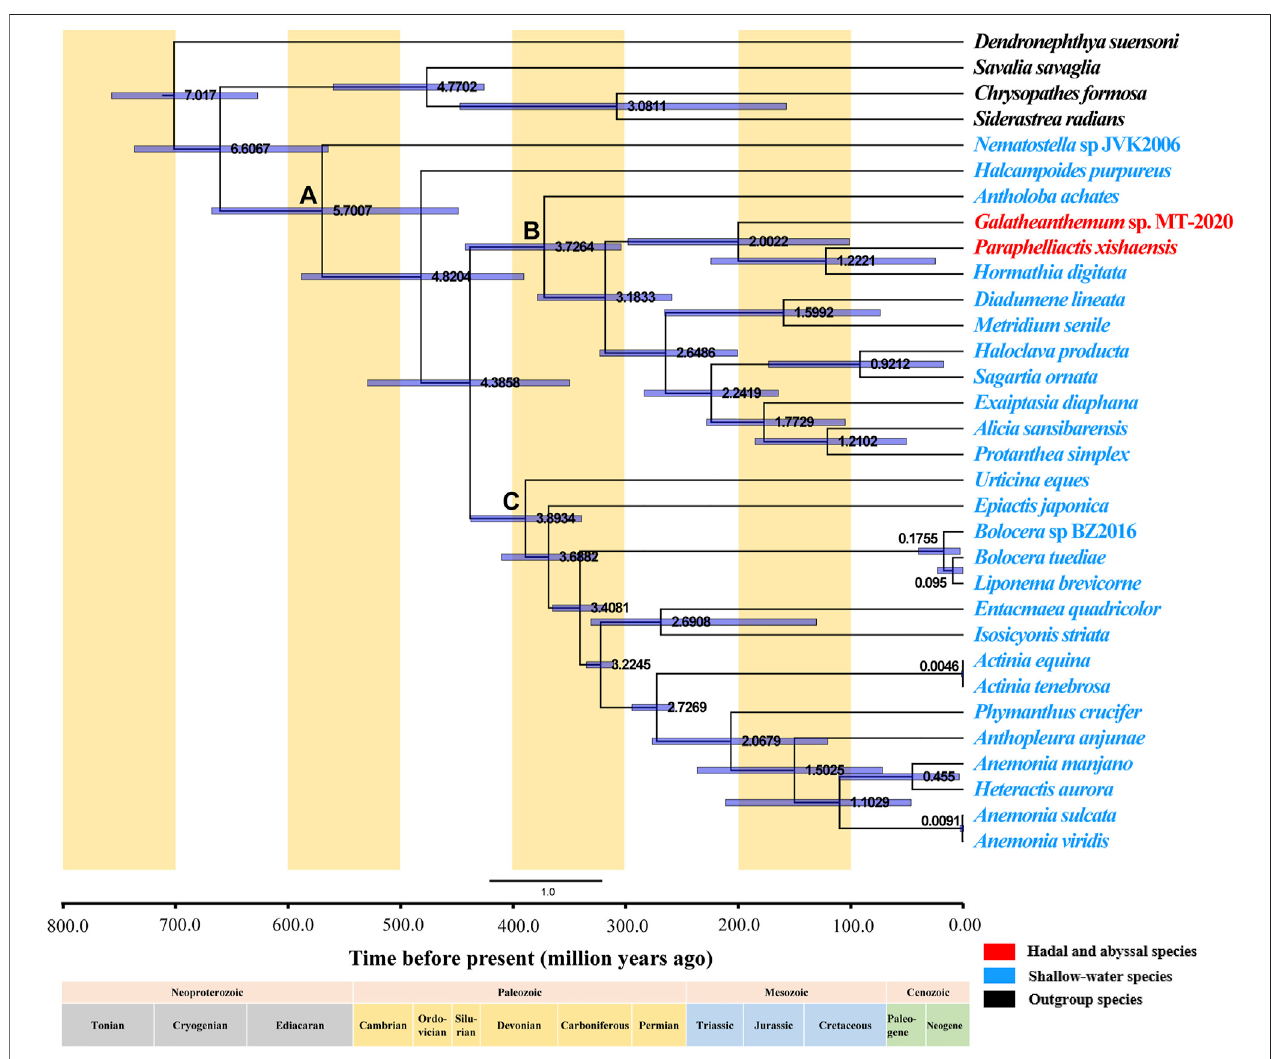
FIGURE 7 | Divergence time of Actiniaria estimated by the Bayesian relaxed-molecular clock method. Node bars indicate 95% credible intervals of the estimated divergence time. The hadal and abyssal species are marked in red, the shallow-water species are marked in blue, and the outgroup species are marked in black. The positions of important nodes are marked with (A – C)